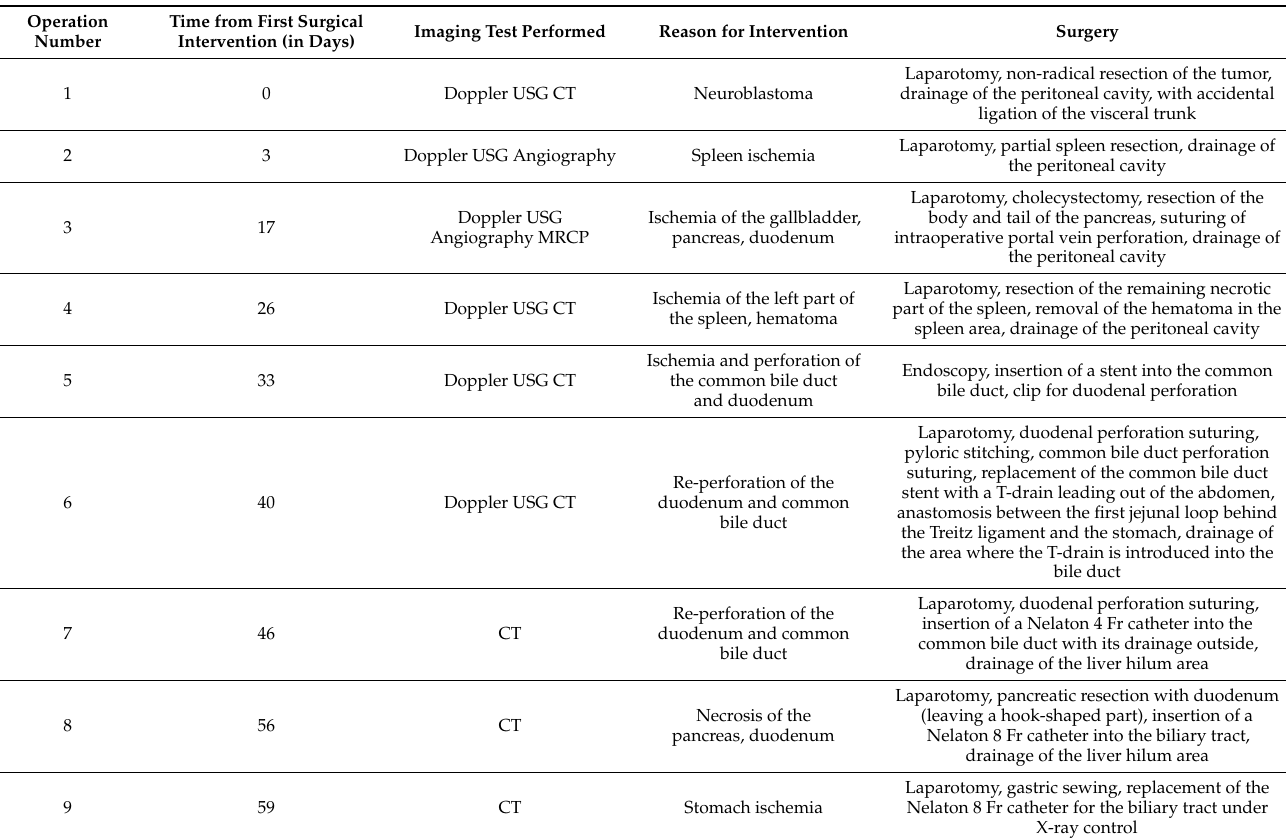
Table 1. The table showing the date of the procedure, the imaging test performed, the reason for the intervention, and the surgical treatment